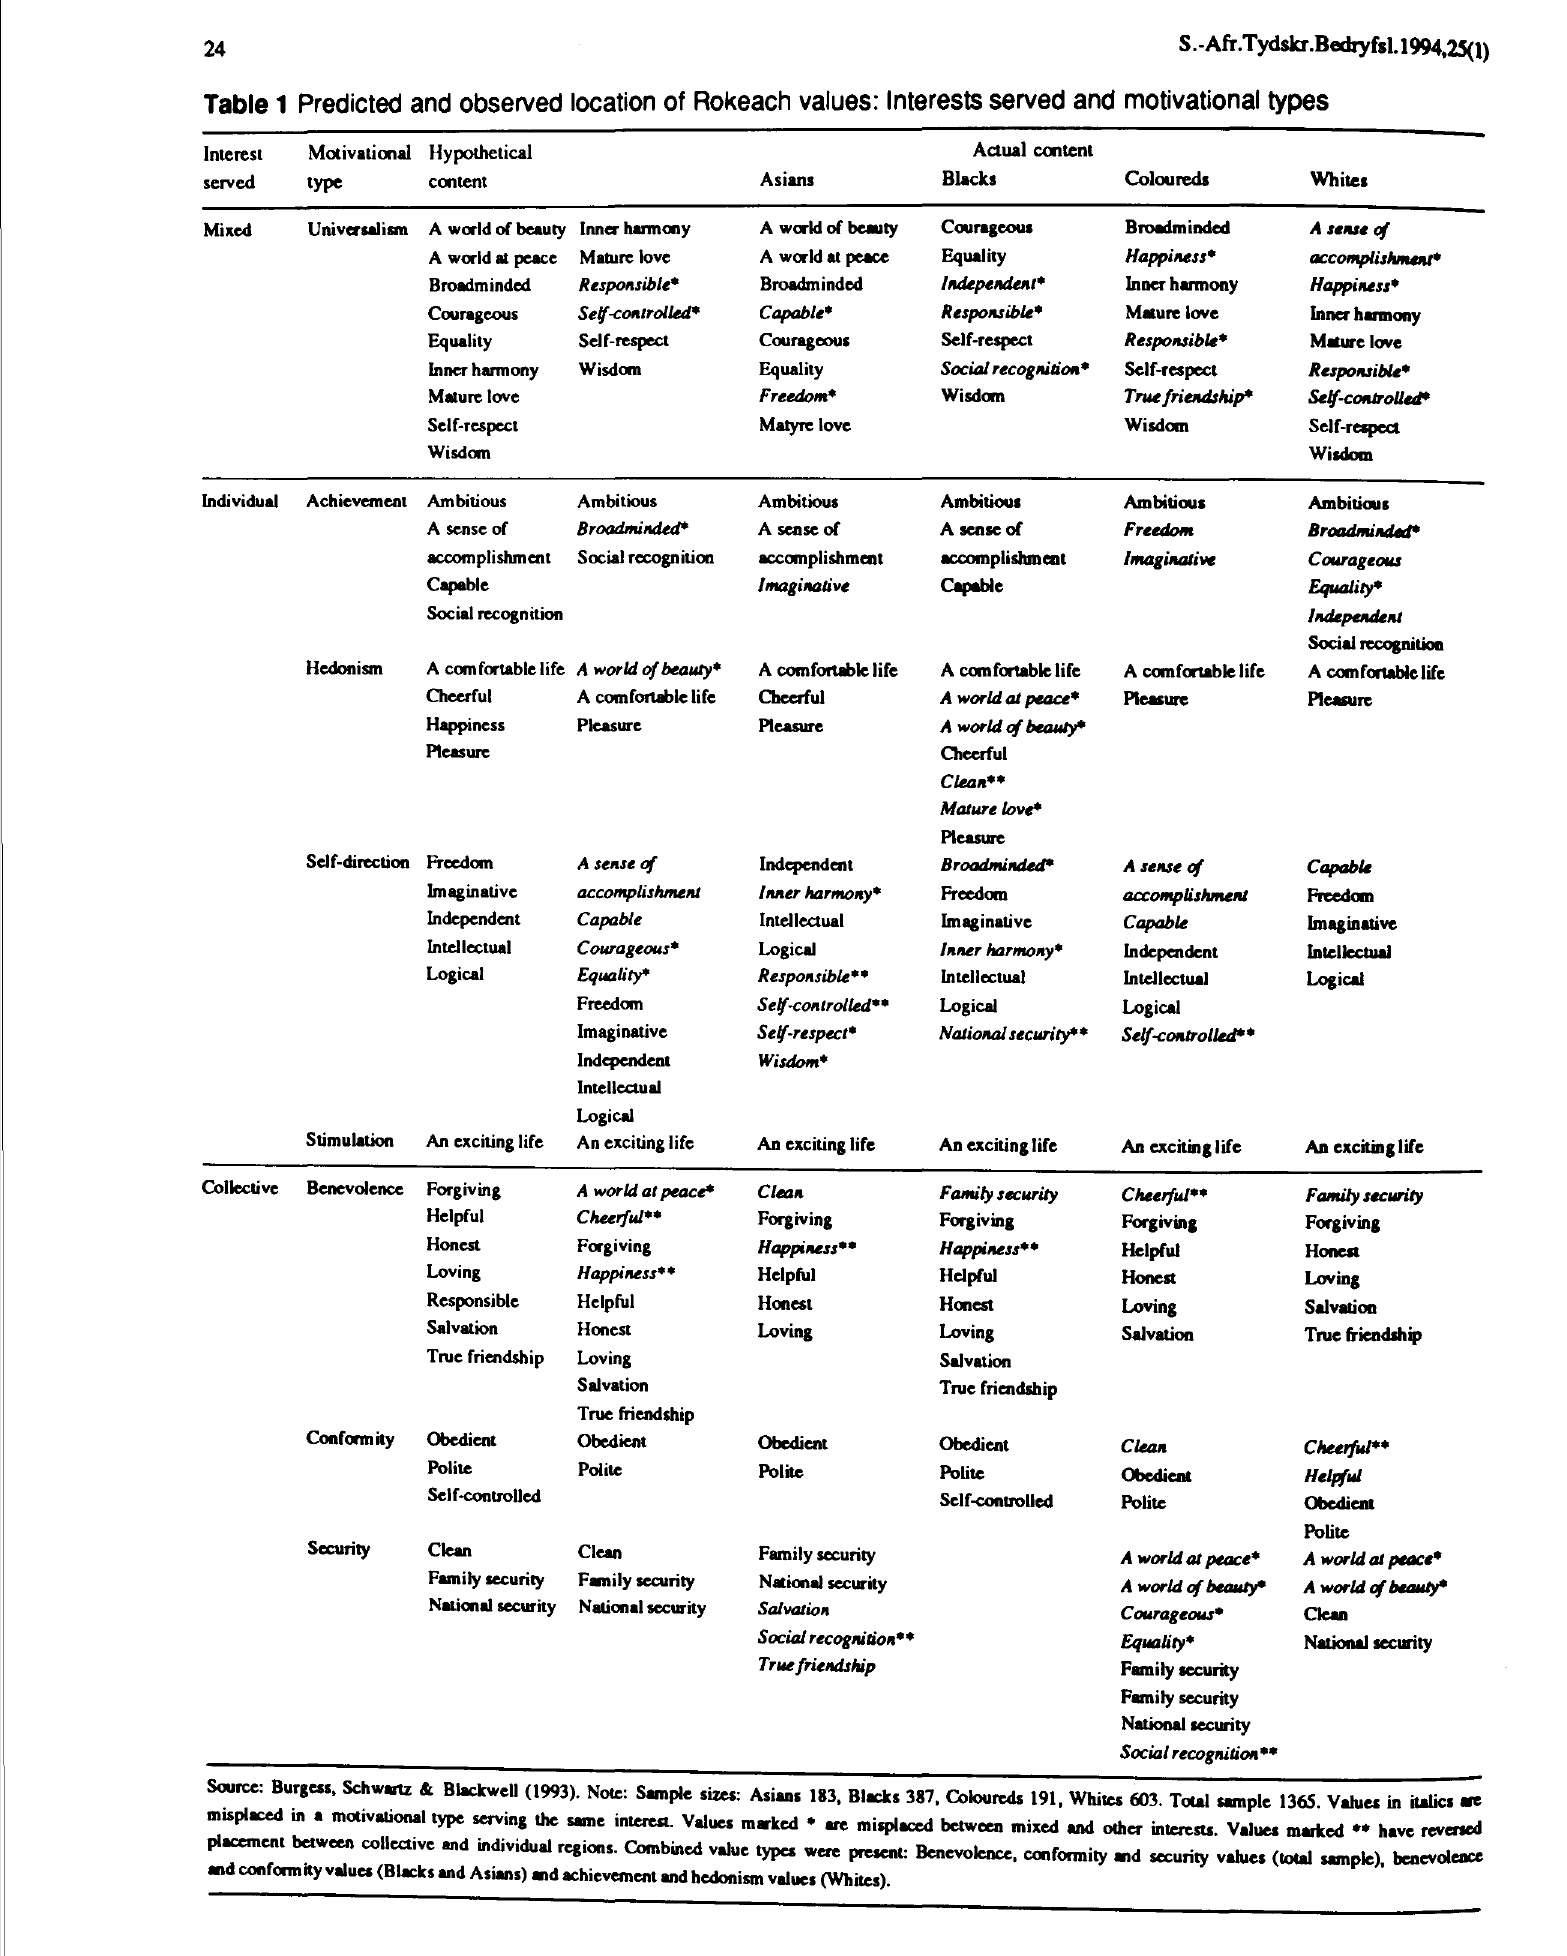
Table 1 Predicted and observed location of Rokeach values: Interests served and motivational types